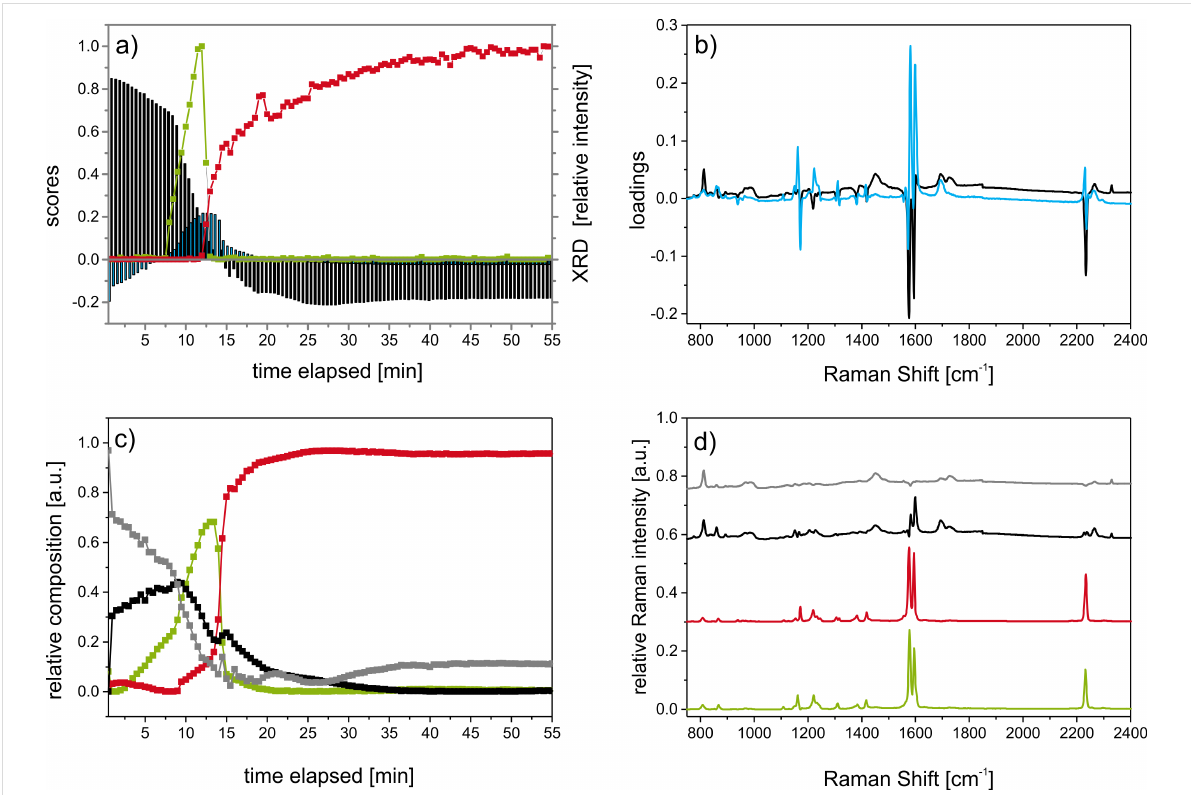
Figure 6: Results of multivariate data analysis of Raman spectra for 30 Hz milling experiments. Principal component analysis (PCA) of Raman data, showing (a) scores, and (b) loadings for (black) PC1 and (blue) PC2. (a) PC1 scores show a decrease in spectral component of 1a in the first minutes – cf. positive spectral signature of loadings of PC1 in (b). The negative scores of PC1 correspond to the negative part of PC1 loadings, i.e., t3c . Scores of PC2 indicate the presence of a compound with spectral features resembling m3c . For comparison, intensity of PXRD Bragg peaks at (green) 2 θ = 13.87° and (red) 2 θ = 14.78° are given in (a) for m3c and t3c, respectively. Multivariate curve resolution (MCR) of (c) composition profiles, and (d) component spectra. Coloring of (c) and (d) are used to indicate corresponding data. (c) Relative phase composition of (black) 1a and the (grey) PMMA-background decrease within the first minutes of the reaction. Simultaneous formation of (green) m3c , shows pronounced increase followed immediately by a rapid decrease. The latter is accompanied by the formation of (red) t3c . In the final stage of the reaction, only contributions from t3c and the PMMA background can be